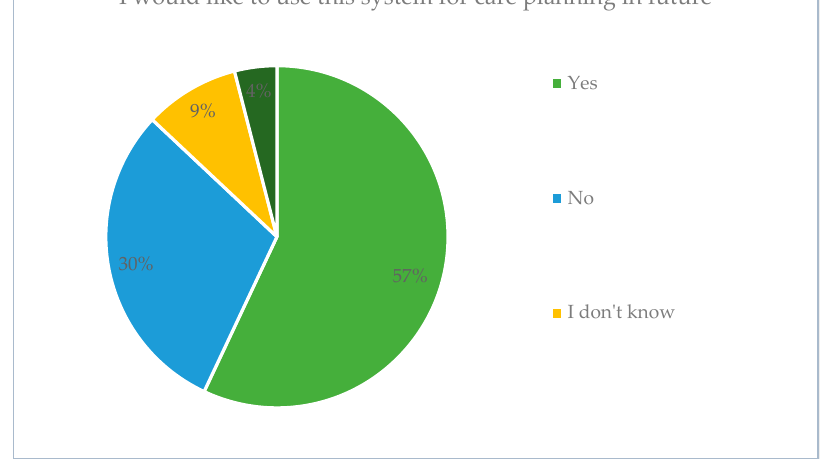
Figure 14. Attitude of the respondents to the implementation of the application for patient care planning.